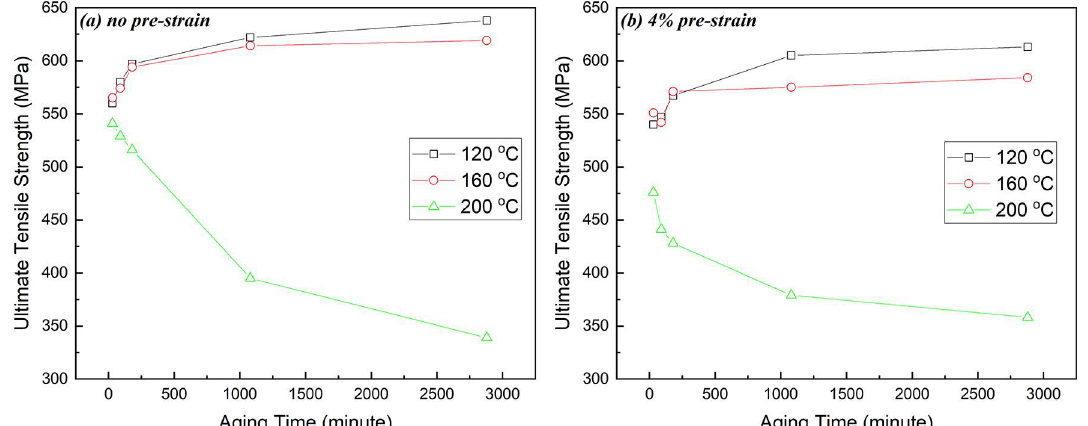
Figure 21. Correlation of strength and aging time for different temperatures for, a) specimens without pre strain, b) specimens with 4% pre strain